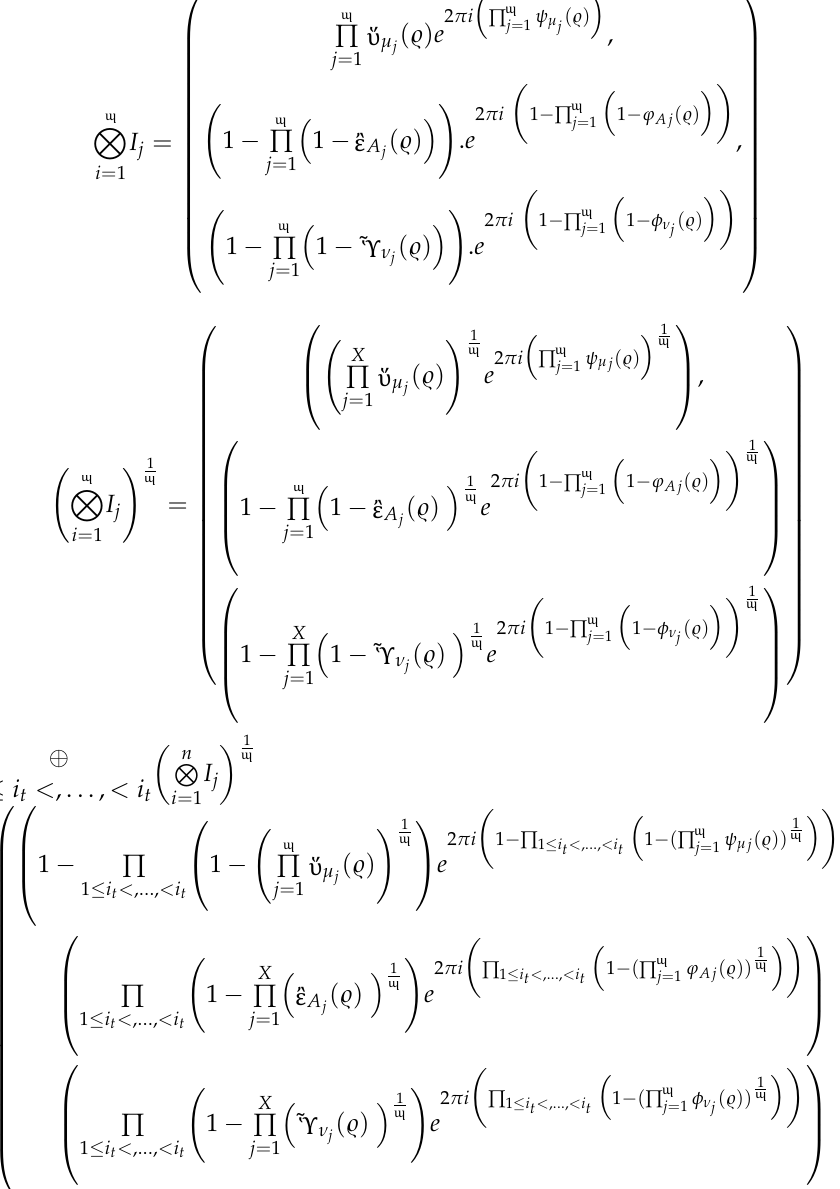
Table 1. Symbols and their